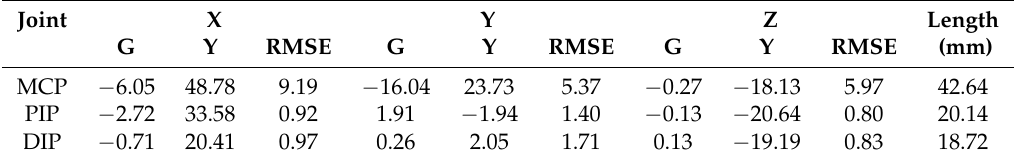
Table 1. Index finger joint position (mm) and finger phalange length (mm). G in the table indicates a gradient of the regression result and the Y means Y-intercept of the